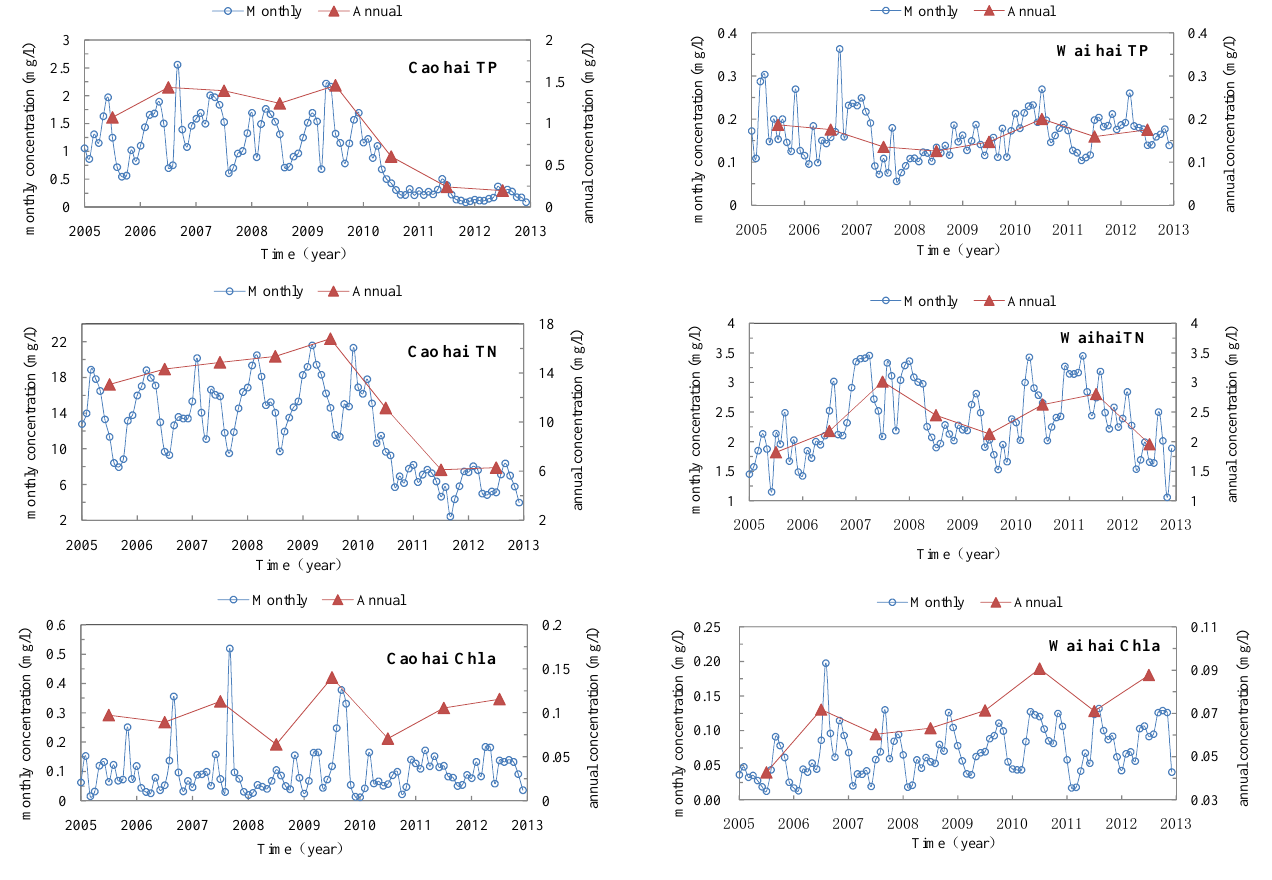
Fig. 2. Temporal changes of TP, TN, and Chl a in Caohai Lake. Fig. 3. Temporal changes of TP, TN, and Chl a in Waihai